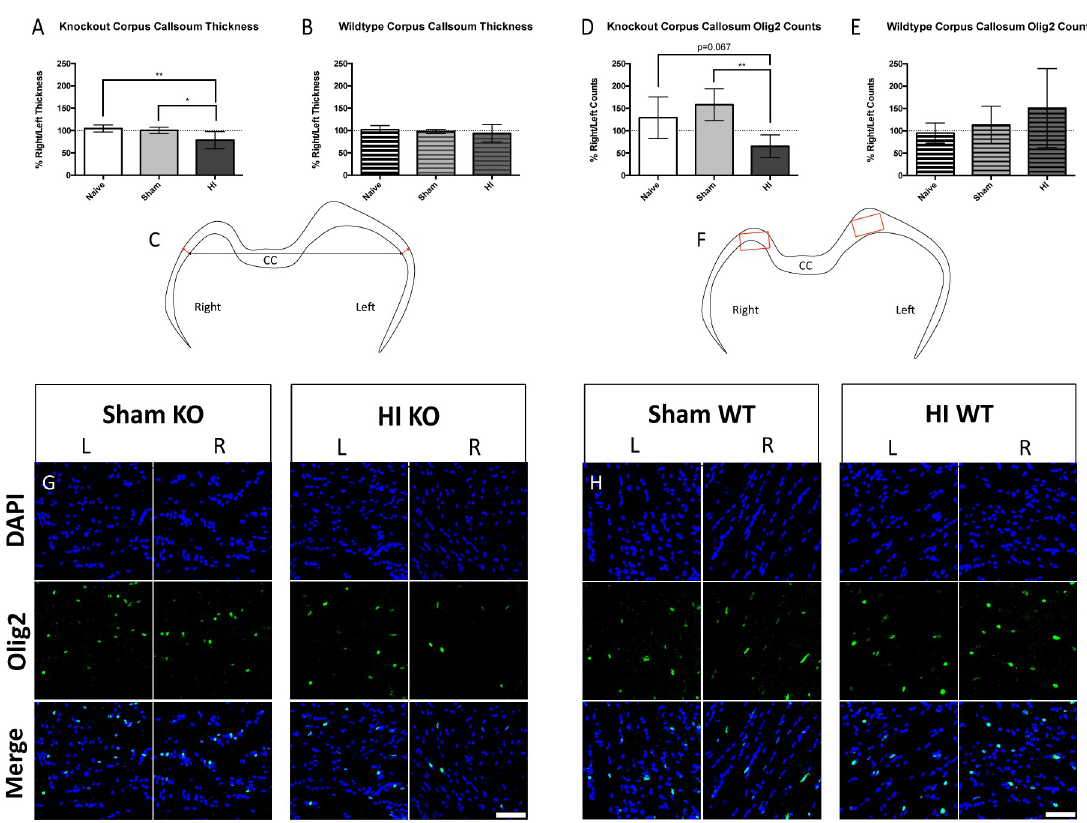
Fig 8. Corpus callosum injury. KO (A) but not WT (B) injured animals displayed reductions in thickness of the corpus callosum in the right hemisphere. (C) Landmarking for corpus callosum thickness was performed from the midline (black arrows) and measurement locations are shown as red arrows. There was a trend toward a reduction in oligodendrocyte numbers in the corpus callosum in KO (D) but not in WT (E) injured animals. (F) Measurements for oligodendrocyte counts are delineated by red boxes. Representative immunofluorescence in the corpus callosum of KO Sham (G left), KO injured (G right), WT Sham (H left), and WT injured (H right) animals in the right and left hemispheres (blue = DAPI, green = Olig2). Scale bars = 50 μ m, 60x. Error bars = ± SD. � p < 0.05, �� p < 0.01.